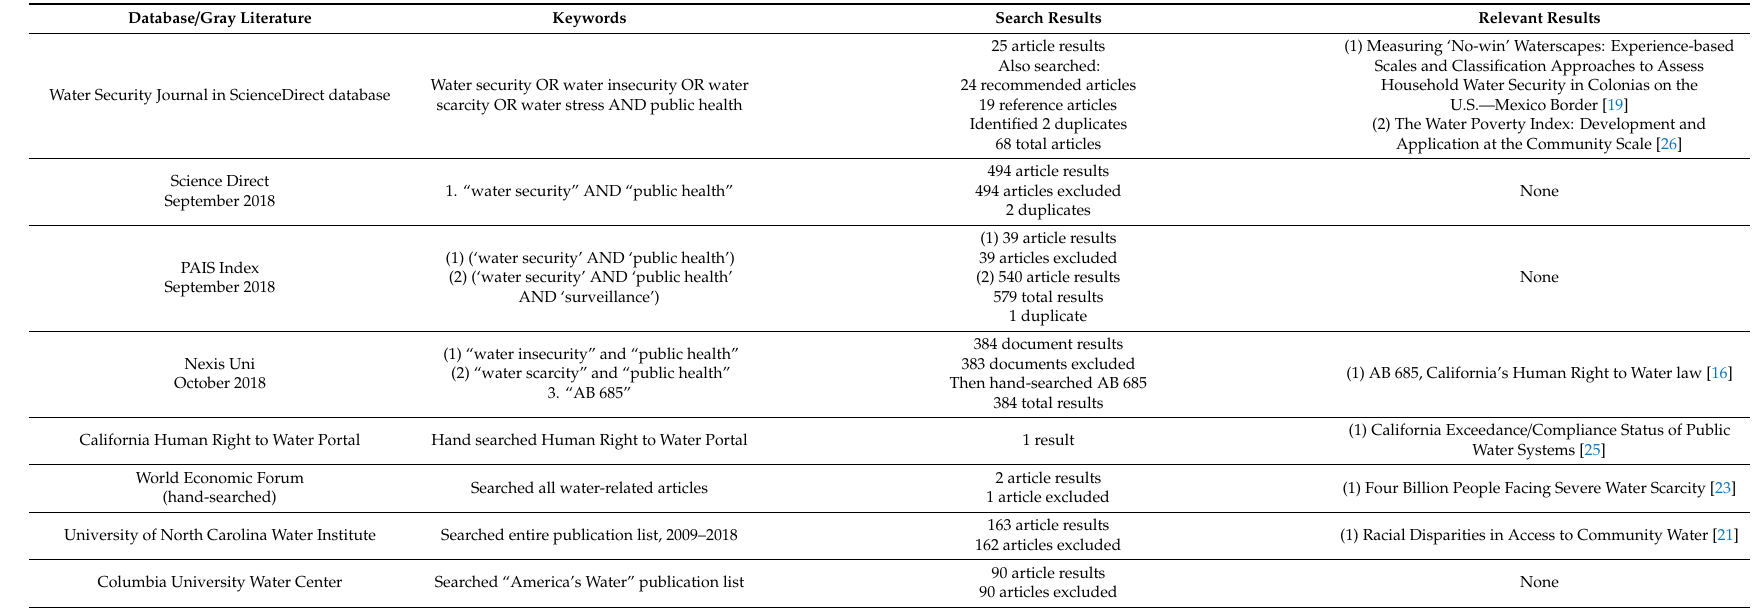
Table A2. Literature Search